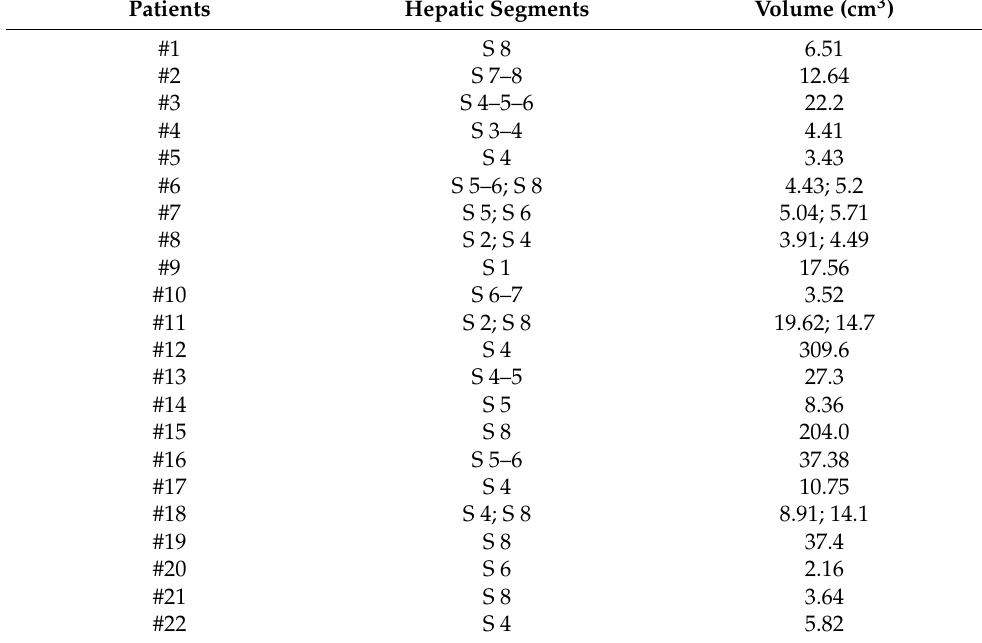
Table 2. Metastatic sites treated with